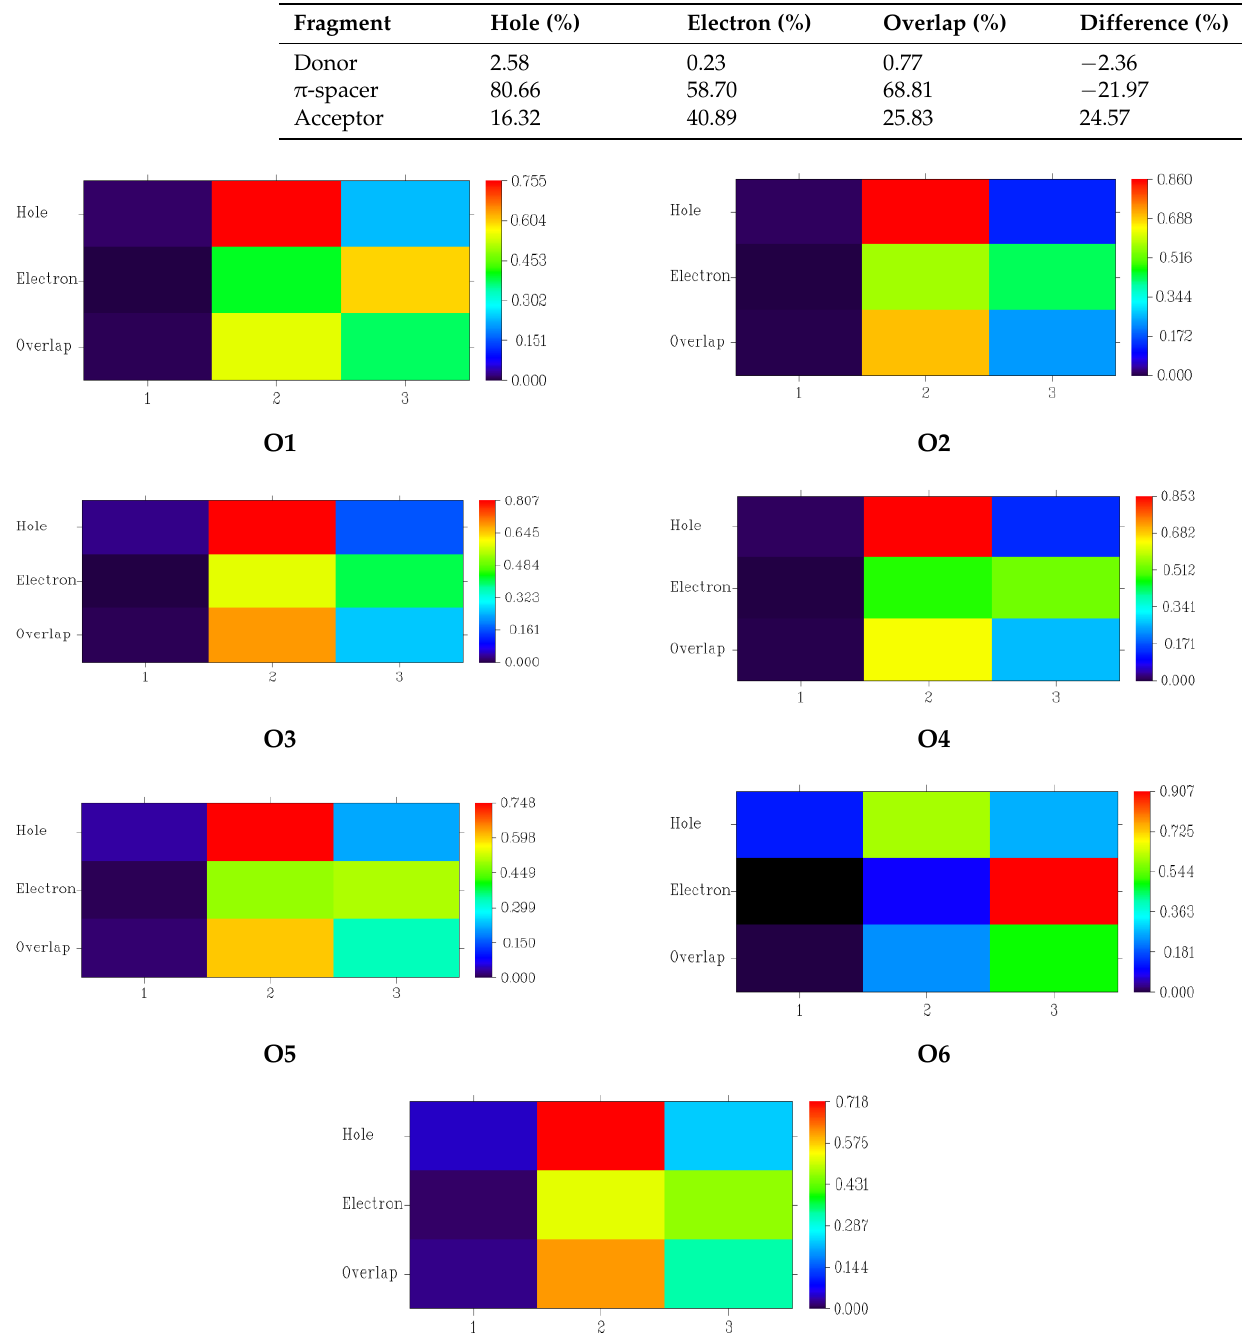
Table 6. Fragment contribution to electron–hole overlap in O3 .